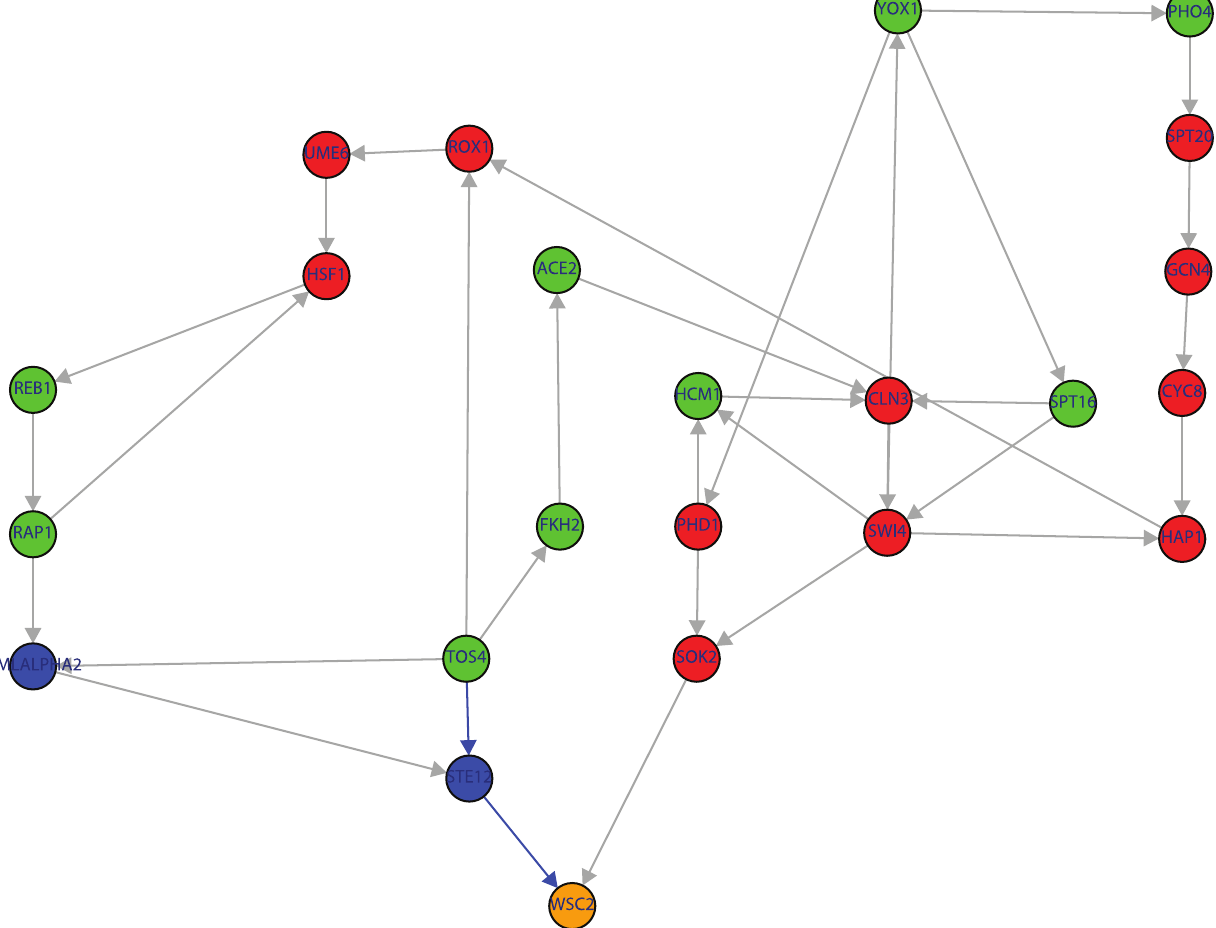
Figure 2. Subnetwork of the TRN consisting of 23 genes (color code as in Fig. 1). The shown subnetwork complements the results in table 1 by providing detailed information about the genes involved in the shortest paths. Blue edges indicate the shortest path from TOS4 R STE12 R WSC2.